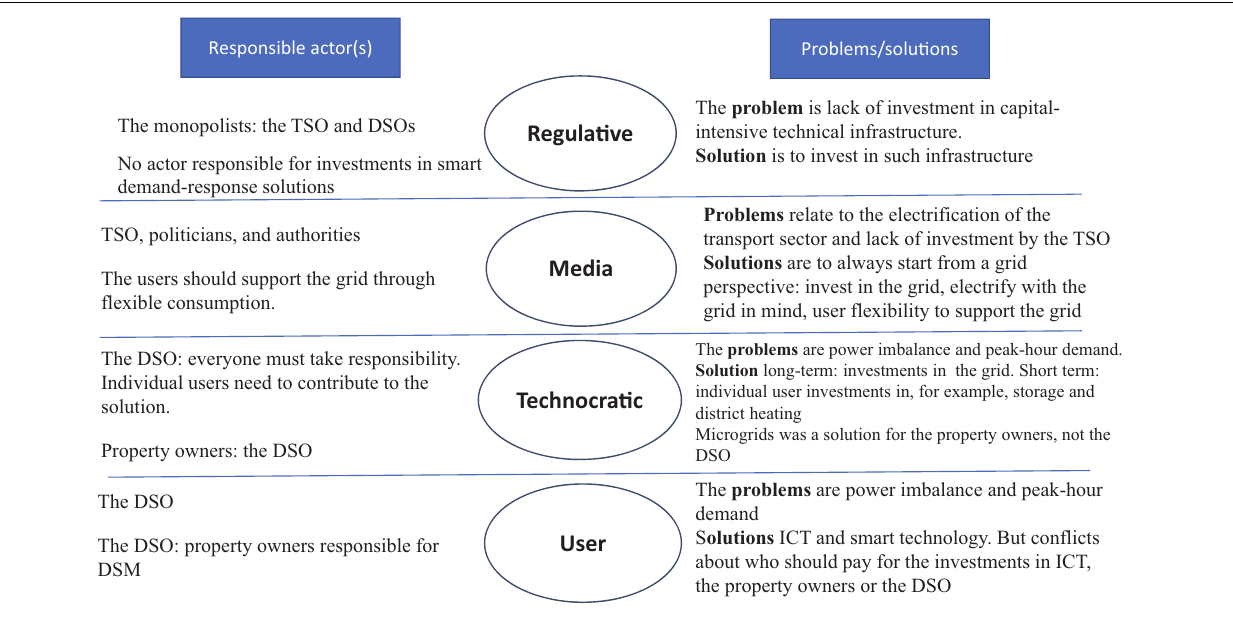
FIGURE 6 | Problem and solutions as discussed in different